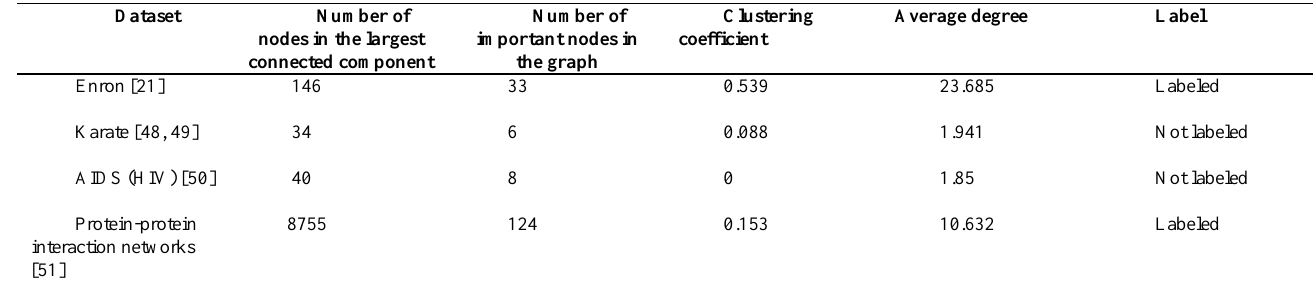
Table 1. Basic statistical information of 4 real-world